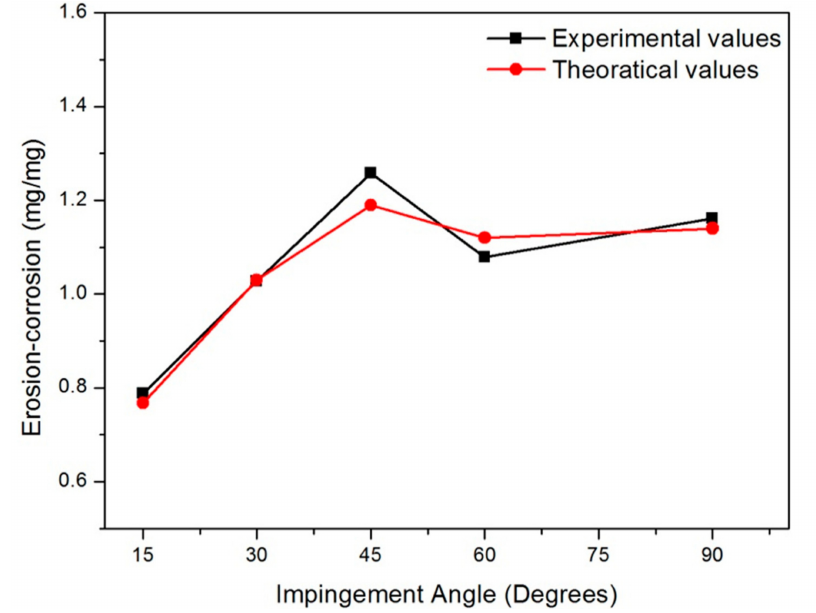
Figure 7. A comparison between the experimental erosion corrosion rate and theoretical data calculated using Finnie model at 12 m/s fluid impact